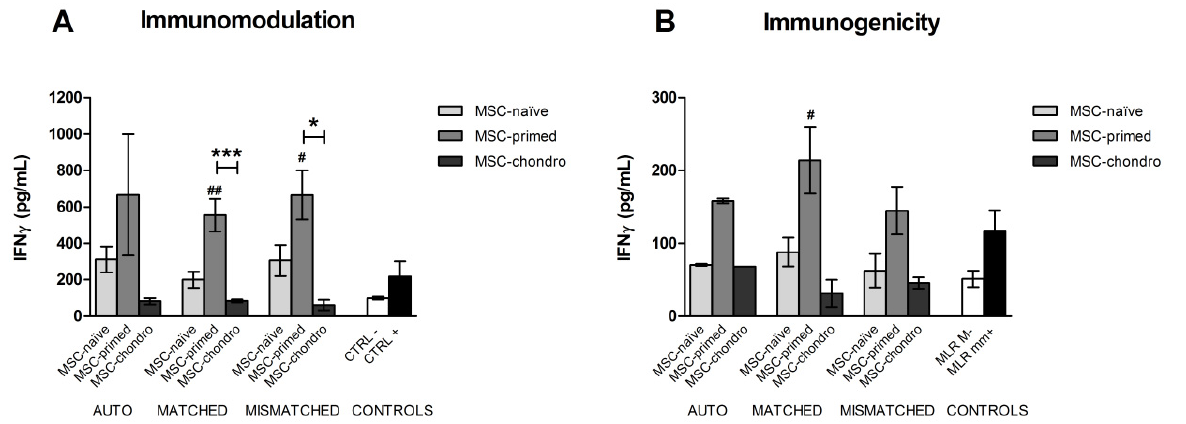
Figure 7. Mean ± SEM concentration (pg/mL) of interferon gamma (IFN ɣ ) in co-culture supernatants from immunomodulatory ( A ) and immunogenicity ( B ) assays. Phytohemagglutinin (PHA)-activated PBLs ( A ) or non-activated PBLs ( B ) were exposed in vitro to MSC-naïve (light grey bar), MSC-primed (medium grey bar) and MSC-chondro (dark grey bar). Co-cultures of MSCs and PBLs were autologous ( n = 3) or allogeneic, matched ( n = 8) or mismatched ( n = 7) for the MHC. Significant differences of each condition over the positive controls were not observed. Significant differences over the negative controls are represented by hashes (#) above the corresponding bar (# = p < 0.05; ## = p < 0.01). Significant differences between experimental conditions are represented by squared line with asterisk (* = p < 0.05; *** = p < 0.001).